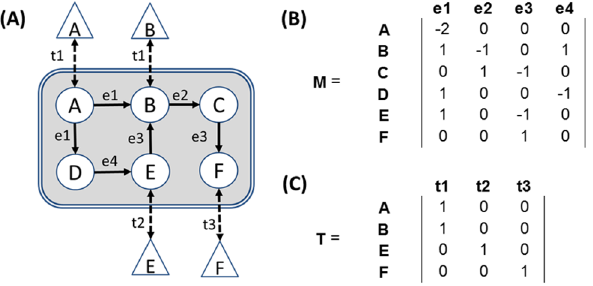
Fig 1. Metabolomic and Transportomic Modeling. In (A), a simplified metabolomic/transportomic network is featured. Triangles are extracellular compounds, circles are intracellular compounds, and double-line is cellular membrane. Dashed edges t1-t3 are transmembrane transport interactions. Solid arrows e1-e4 are directed metabolic transformations. Each enzyme or transporter annotation can be associated with one or more compounds. (B-C) represents the network in (A) transformed in matrices for use in PRMT and PRTT calculations. In (B), matrix does not consider enzymatic flux or mass balanced reactions. In (C), the transportome matrix is constructed such that a ‘ 0 ’ indicates that a ligand is not transported and a ‘ 1 ’ indicates that a ligand is transported by a transporter of a given annotation. For example, in the cartoon above, ligands A and B are transported by a transporter annotated with function ‘ t1 ’